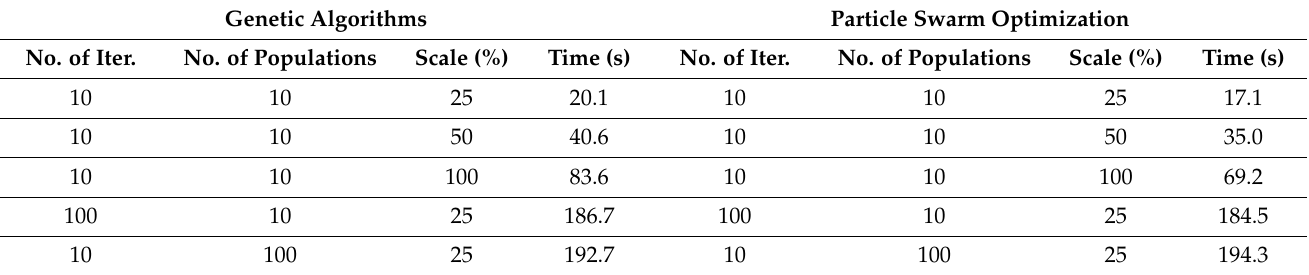
Table 4. Comparative analysis of computational times for solution algorithms. Genetic Algorithms Particle Swarm